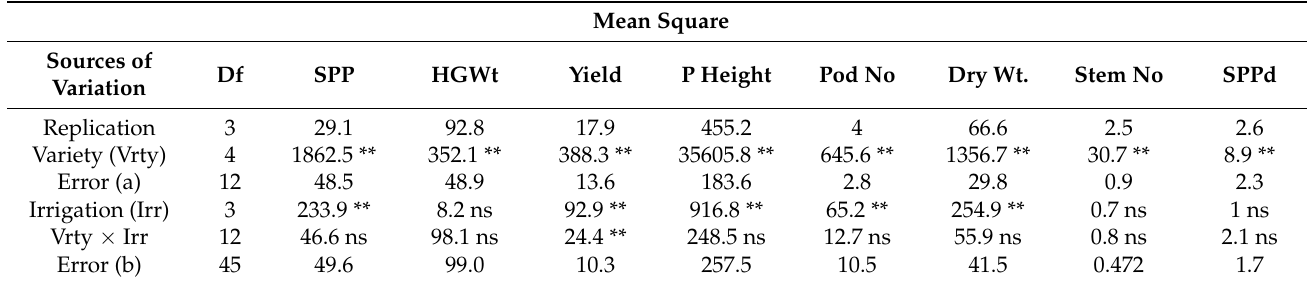
Table 1. Analysis of variance for plant growth parameters of bean genotypes in irrigation treatments during the 2018 growing season.